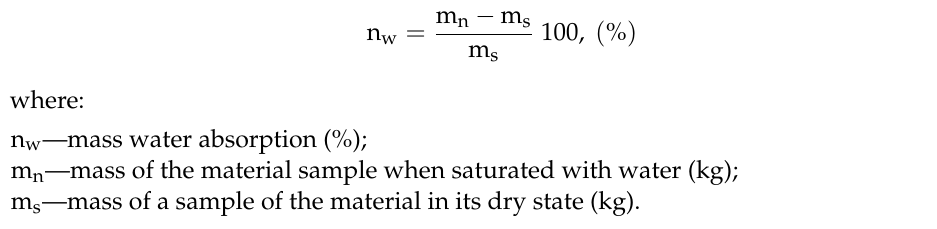
table. The bulk density was evaluated by measuring the weight of a 1000 cm 3 container filled with mortar in two layers. Each layer was vibrated in order to remove any air